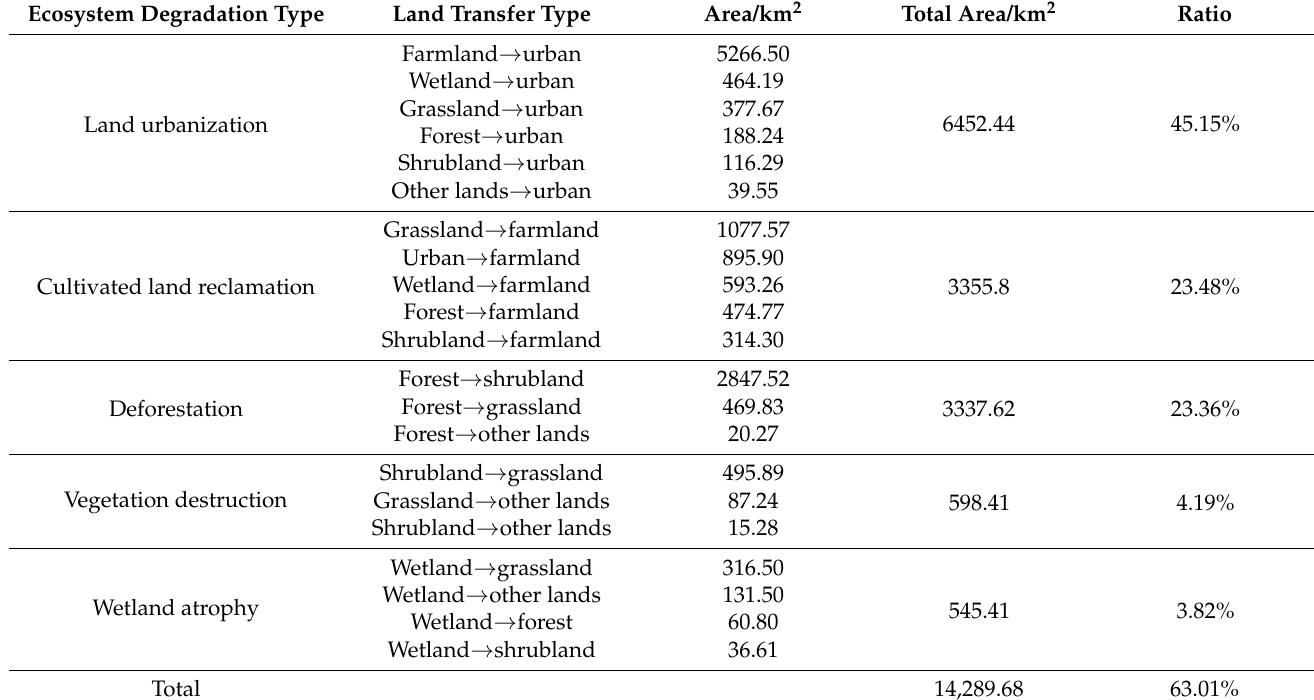
Table 2. Ecosystem degradation of the Beijing–Tianjin–Hebei urban agglomeration from 2000 to